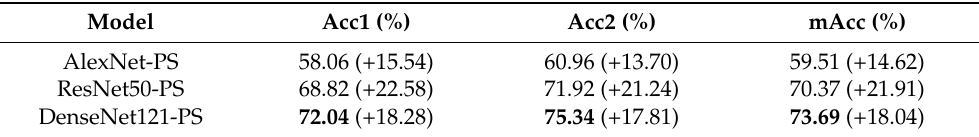
Table 5. Performance of three CNNs with settlement environment maps on the test set. The best metrics are highlighted in bold font.